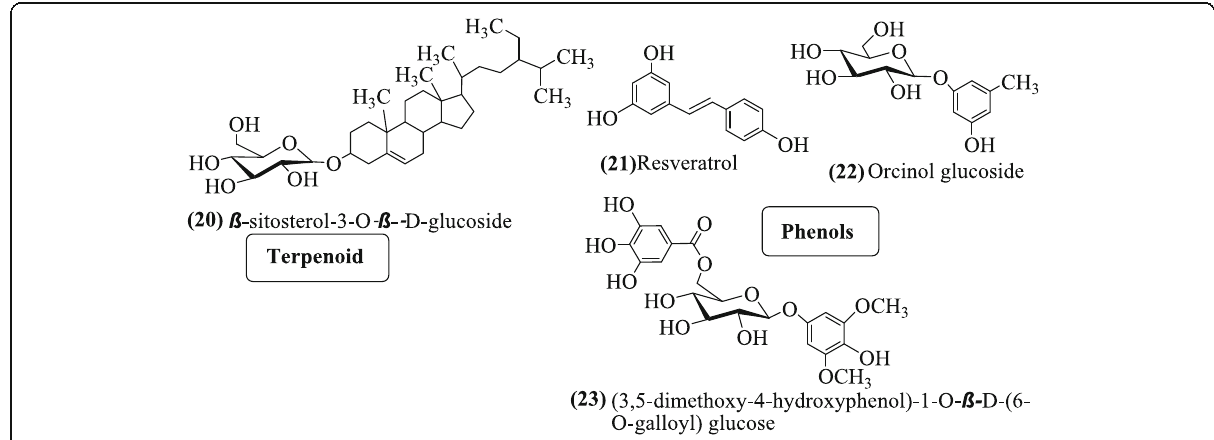
Fig. 5 Isolated terpenoid and phenol compounds from the root extracts of R.